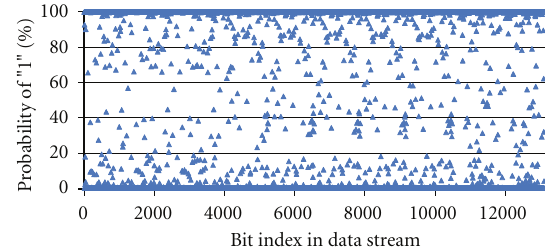
Figure 2: Probability of bit value “1” over 10 k measurements on device